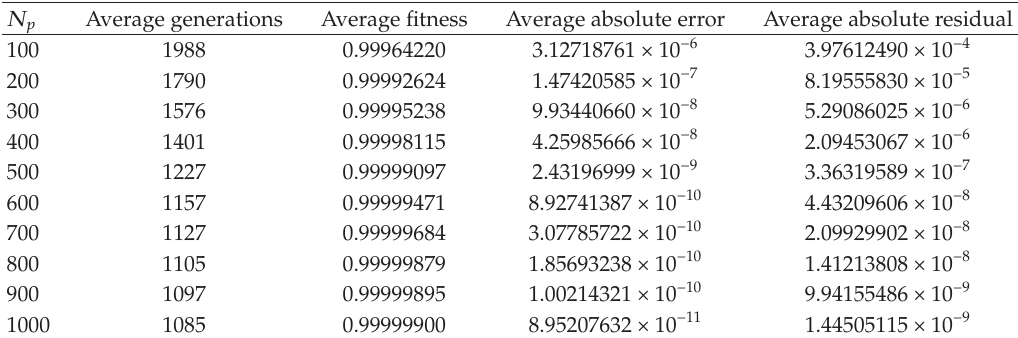
Table 13: The e ff ect of the population size on the convergence speed and the corresponding error for Problem